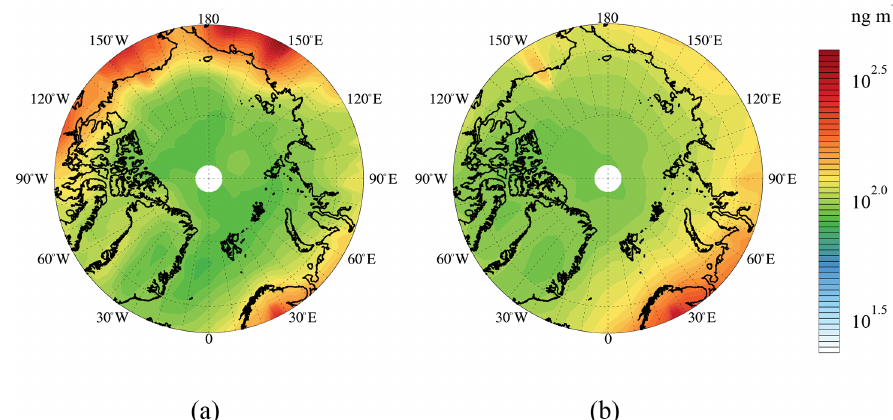
Figure 2. Spatial distribution of near-surface BC concentrations in (a) summer and (b) winter in the Arctic in